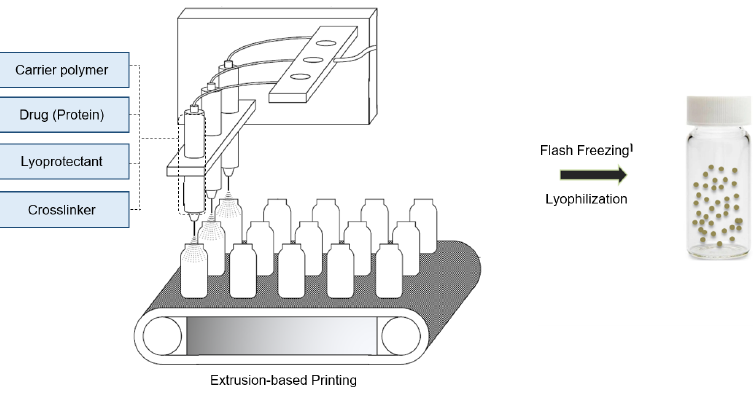
Figure 1. Schematic of Sprayed Multi-Adsorbed Droplet Reposing Technology (SMART).